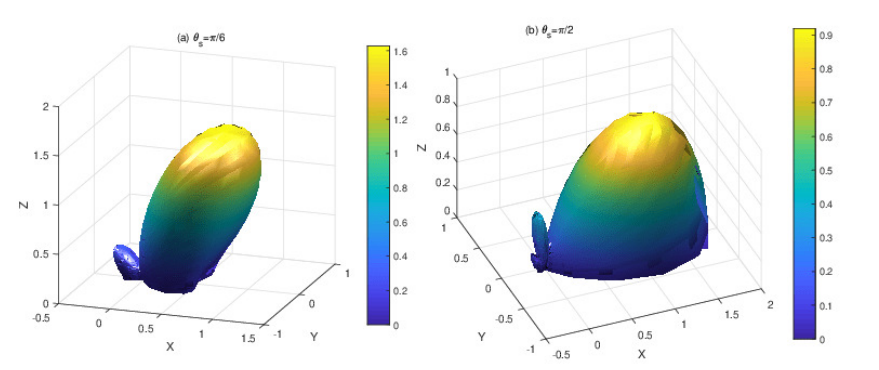
Figure 6. Variation of radiation pattern against Floquet states and application of superposition theorem for 10 elements of antenna array (uni-dimentionnal configuration) at 77 GHz: obtained by the MoM-GEC method.